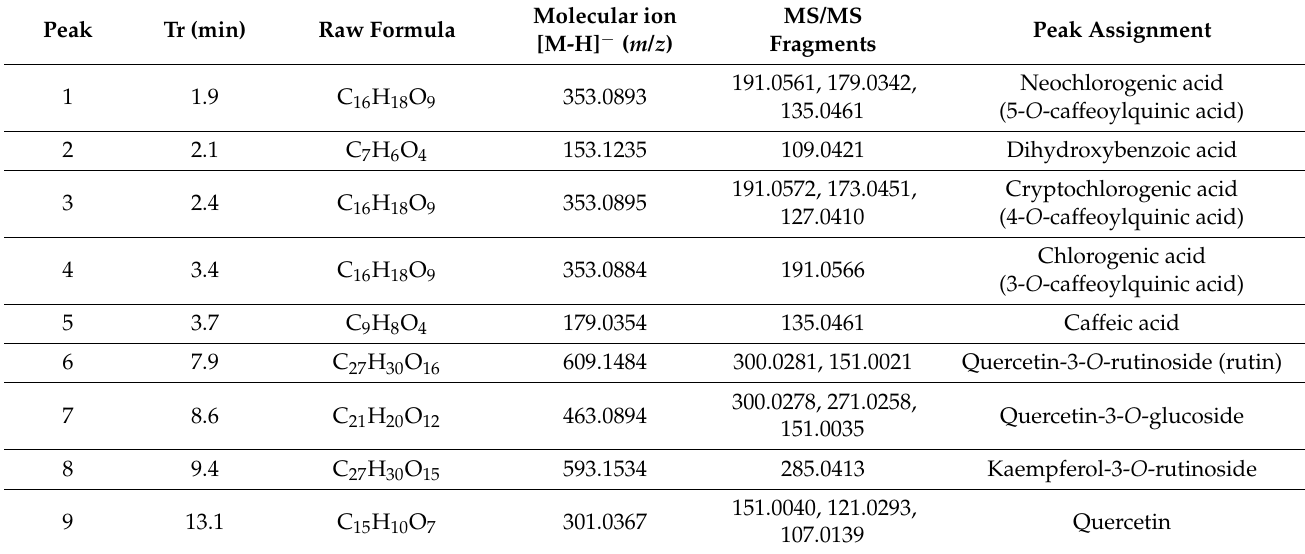
Table 1. Peaks detected in extracts of fruits of S. nigra by HPLC-ESI-Q-ToF analysis (peak numbers are referred to the chromatograms presented in Supplementary Figure S1).